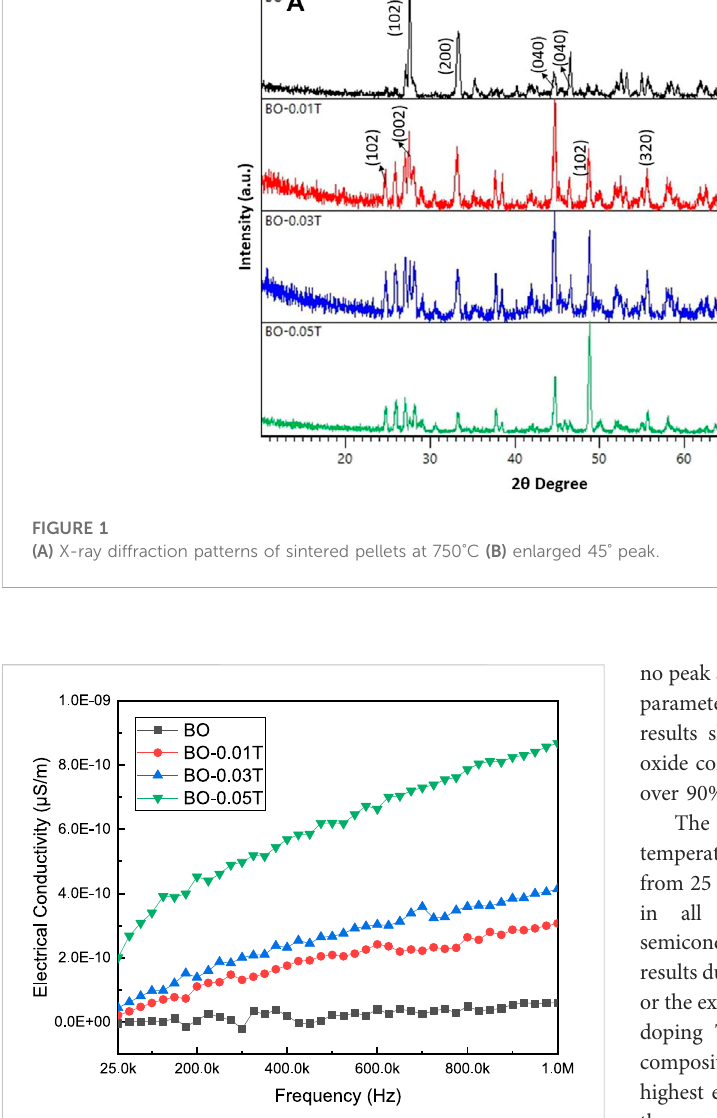
FIGURE 2 Electrical Conductivities of sintered pellets at 750 ° C as a function of